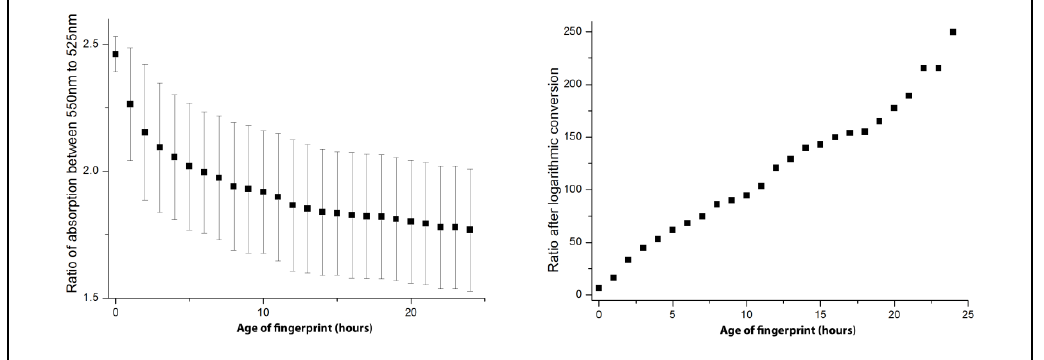
Figure 8. Effect of time on the absorption ratio of 550 and 525 nm ( left ) and the logarithmic conversion ( right ) over 24 h.